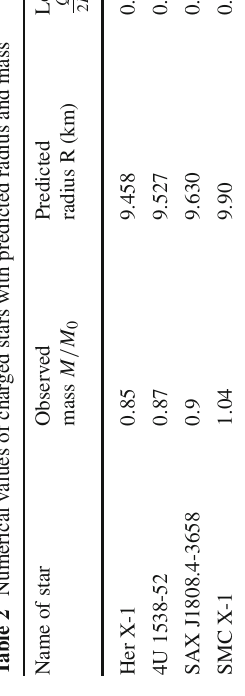
The energy density and pressure profiles depict the real- istic and physical nature of charge matter. Anisotropy and gradients as a combination provide system stability and bal- anced configuration. Our system is electrically charged and composed of suitable charged configurations. Energy condi- tions suggest the proper and real form of charged anisotropic matter composition. The system is well-stable under the adi- abatic index and cracking criteria. EoS components depict the real nature of matter composition. Whereas the system is physically admissible according to the mass, redshift, and compactification parameters. Table 1 shows the predicted radii for different compact objects with the total charge on the boundary in the Coulomb (C) unit. However, the lower and upper bound of the mass–radius ratio is presented in Table 2 along with the surface redshift of the obtained com- pact objects. From this Table 2, it is clear that our model satisfies the lower and upper limits of the mass ratio as well as the surface redshift upper limit. It is clear from Table 1 and Table 2 that for star Her X-1 the amount of charge is 5 . 031 × 10 18 C and redshift is 0 . 825387, for star 4U 1538- 52 the amount of charge is 4 . 133 × 10 18 C and redshift is 0 . 826626, for star SAX J1808.4-3658 the amount of charge is 6 , 467 × 10 18 C and redshift is 0 . 829549, for star SMC X-1 the amount of charge is 0 . 00 C and redshift is 0 . 788741. Finally, we would like to mention that our study is physically valid and may be beneficial for further studies in the context of f ( Q ) -gravity